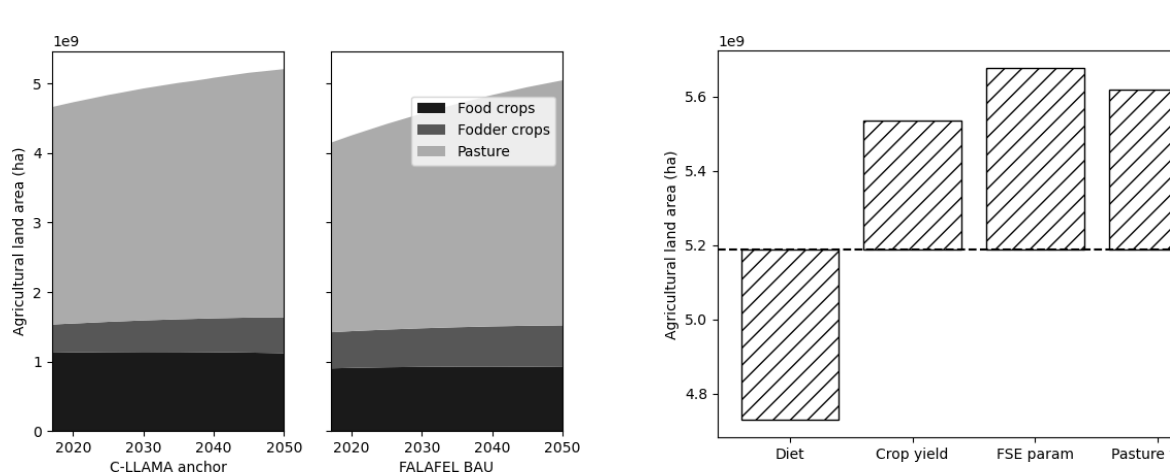
Figure 4. Aggregated global land use for food production in the C-LLAMA anchor scenario and a “business-as-usual” (BAU) FALAFEL scenario. FALAFEL accounts for the production of some non-food crops; however, they are excluded for this compara- tive figure.